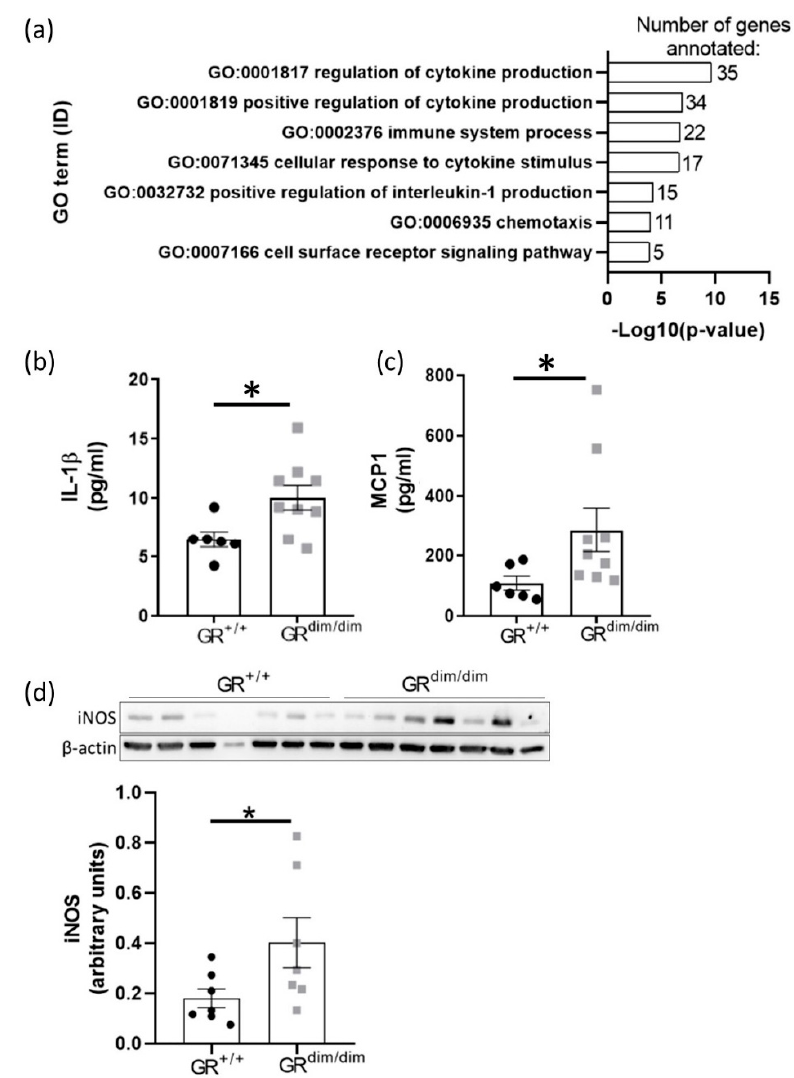
Figure 4. Enhanced cytokine and chemokine signaling in GR dim/dim and GR +/+ mice after HS. ( a ) Gene ontology (GO) mapping of upregulated genes in lung samples from GR dim/dim mice with indication of the gene number per GO term in the bars. The X -axis shows the significance for annotation with the respective GO term. ( b ) IL-1 β and ( c ) MCP1 concentration in BAL samples obtained at the end of the experiment were increased in GR dim/dim compared to GR +/+ mice. ( d ) GR dim/dim mice had higher iNOS protein level in lung samples than GR +/+ mice after HS. Significance was analyzed with unpaired Mann-Whitney and indicated according to * p < 0.05.